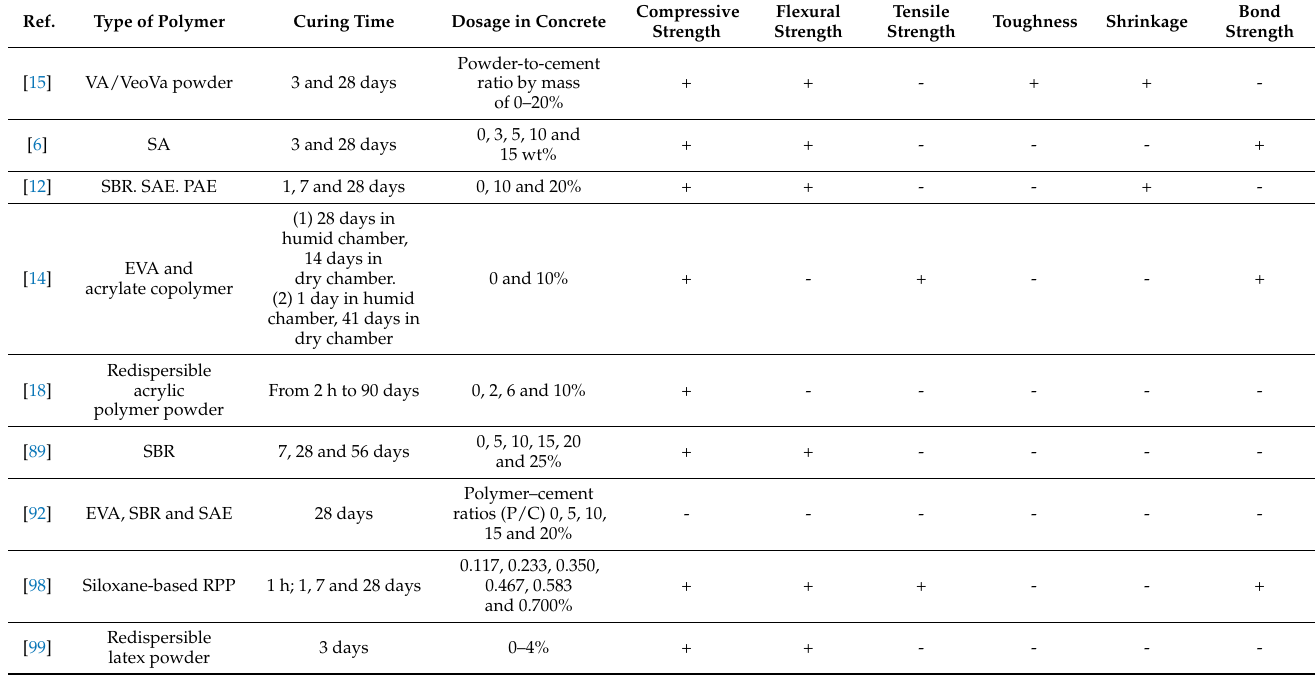
Table 3. Mechanical properties analysed in the case of cement–polymer materials.